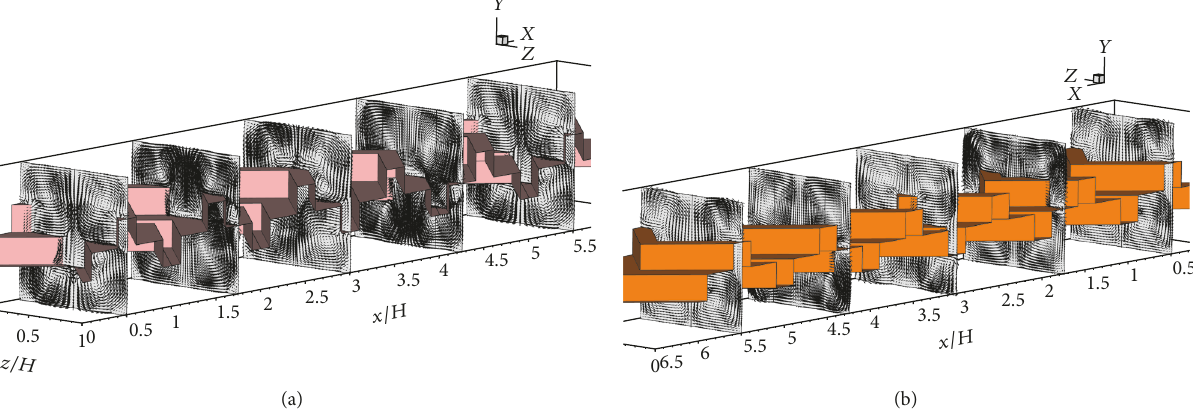
Figure 4: Tangential velocity vector in transverse planes of the square channel heat exchanger inserted with 45 ∘ V-wavy plate at Re = 3000 for (a) V-Downstream and (b) V-Upstream.